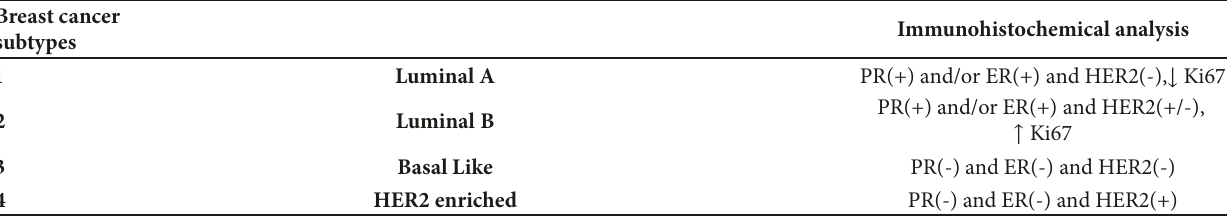
Table 1: Breast cancer subtypes and expression of biological